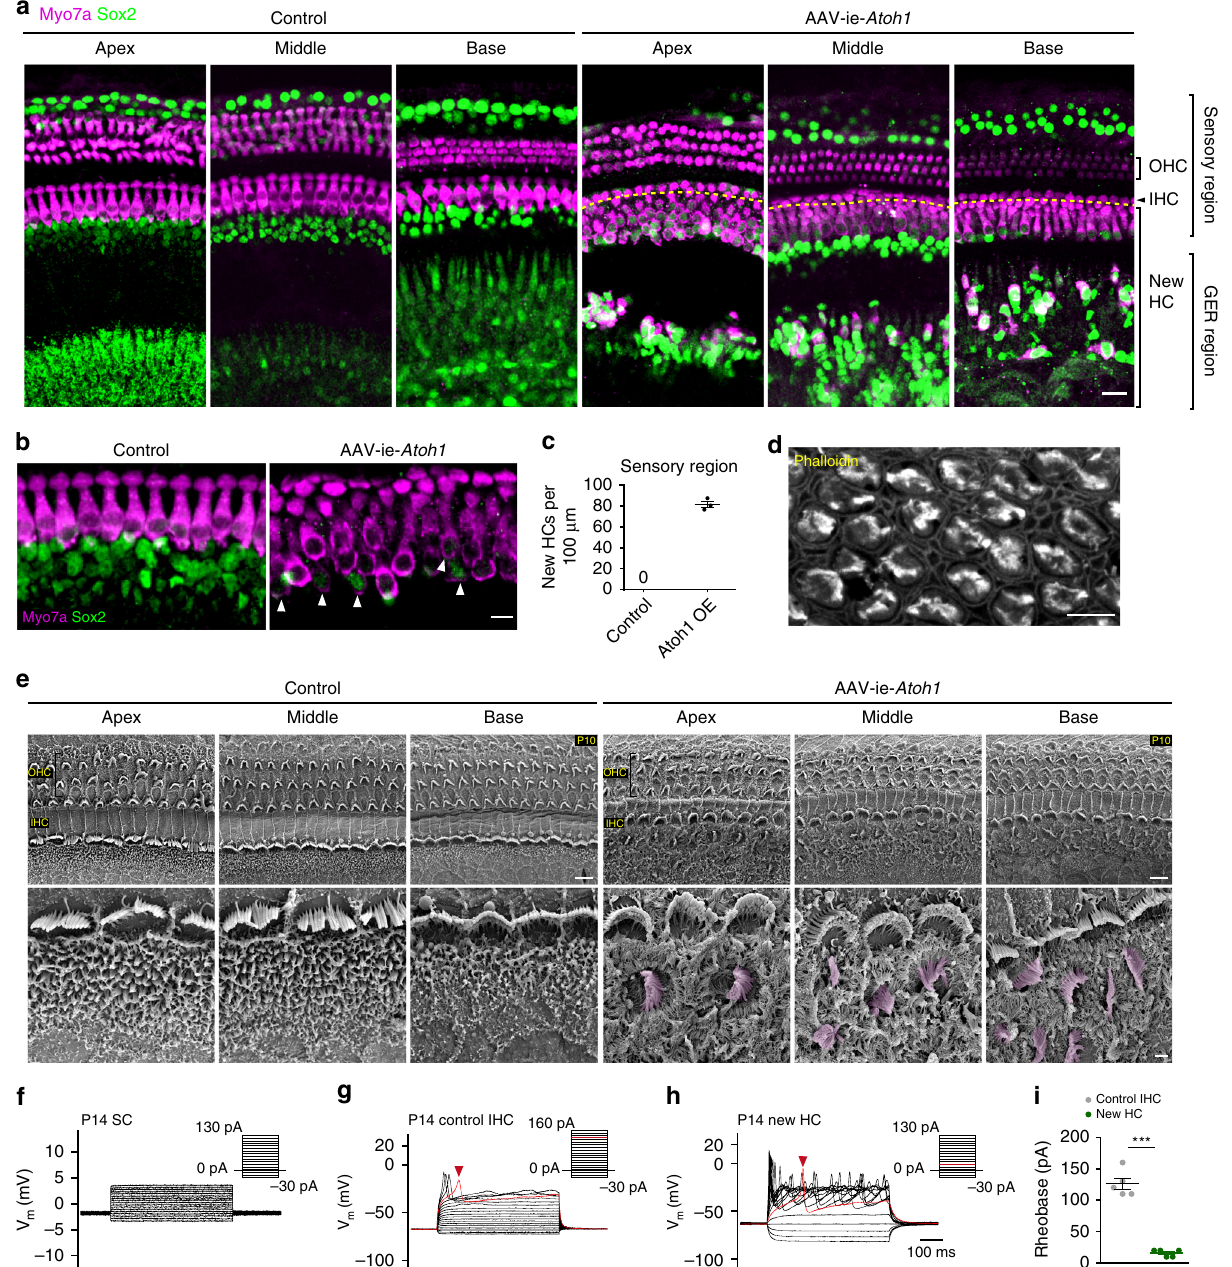
Fig. 5 Adeno-associated virus-inner ear- Atoh1 (AAV-ie- Atoh1 ) induces new hair cells (HCs) in vivo with stereocilia. Mice were injected with AAV-ie- Atoh1 (1 × 10 10 genome-containing (particles) (GCs)) at P0 and the cochlea was harvested at P14. a Representative confocal projection image of control and AAV-ie- Atoh1 cochlea. Scale bar, 20 µ m. b Magni fi cation of inner HC (IHC) region of control and AAV-ie- Atoh1 cochlea. White arrows indicate both Sox2- and Myo7a-positive new HCs. Green: Sox2; magenta: Myo7a. Scale bar, 10 µ m. c Number of Myo7a-positive new HCs per 100 μ m in sensory region. Data are shown as mean ± SEM. N = 3. Source data are provided as a Source Data fi le. d Representative confocal image of phalloidin staining of new HCs in AAV-ie- Atoh1 cochlea. Scale bar, 10 µ m. e Scanning electron microscopy (SEM) images of AAV-ie- and AAV-ie- Atoh1- injected cochlea at apical, middle, and basal regions. Regenerated HC-like cells were arti fi cially colored magenta. Scale bars, 5 µ m (upper panels), 1 µ m (lower panels). f Representative membrane responses of P14 supporting cells (SCs) to current. The trace shows action potential generation in response to 10 pA injections. N = 5. g Same as f , but for P14 IHCs. The trace shows action potential generation in response to 10 pA injections. The fi rst action potential was generated by 130 pA injection (red arrow). h Same as f , but for P14 new HC injected with AAV-ie- Atoh1 and the fi rst action potential was generated by 20A injection (red arrow). i Average responses show signi fi cant difference between IHCs and regenerated new HCs. Data are shown as mean ± SEM. p Value is calculated by Student ’ s t test. *** p < 0.001. N = 5. Source data are provided as a Source Data fi